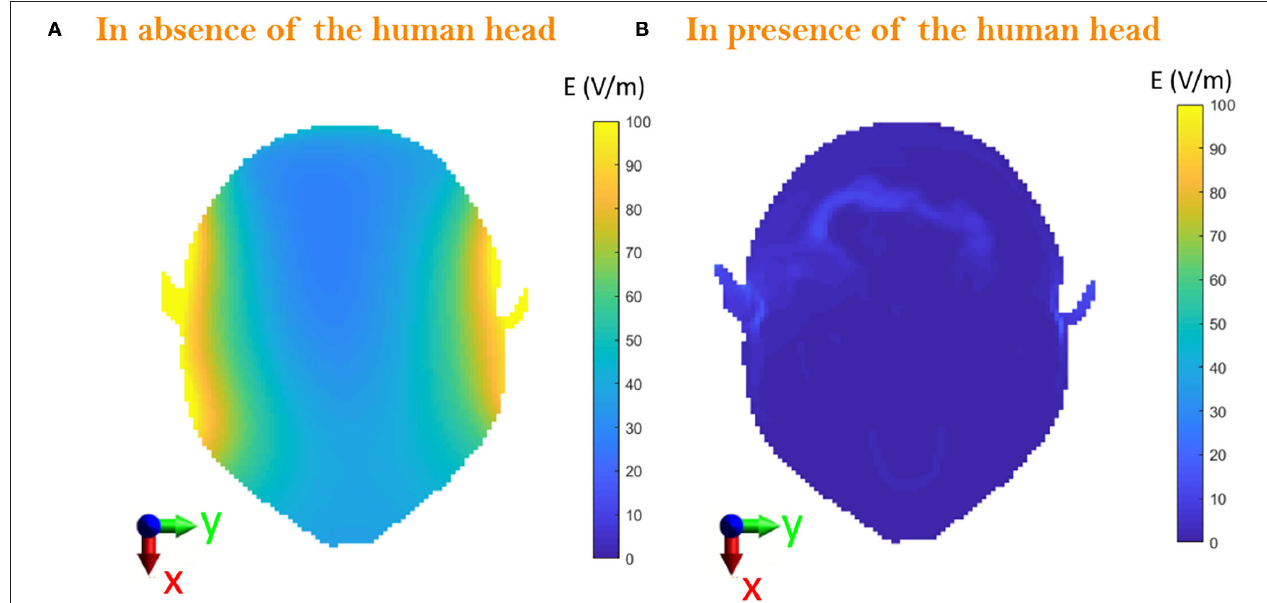
FIGURE 9 | Comparison on the axial plane, XY, between (A) the E-field radiated in the space surrounded by the helmet in absence of human head and (B) the E-field induced inside the head with the operator wearing the helmet at 65cm from the